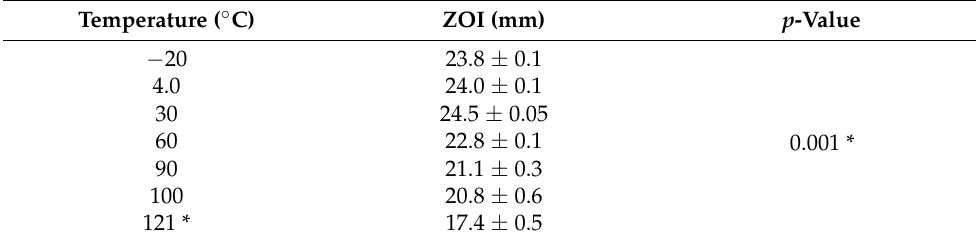
Table 3. Inhibitory effects of enterocin after various temperatures against PA01.